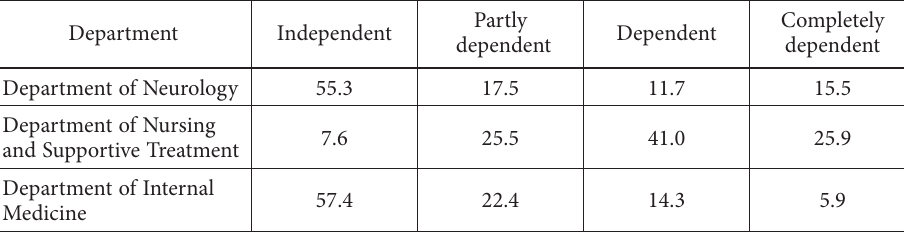
Table 2. Analysis of patients’ level of independence in medical departments,